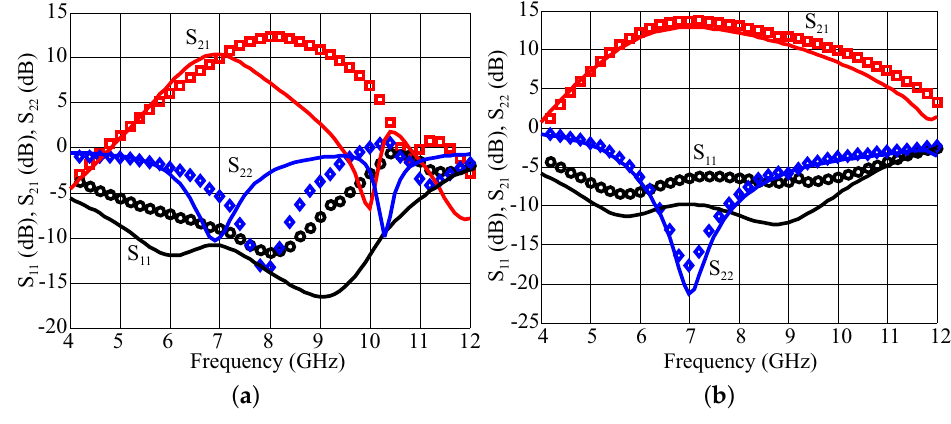
Figure 5. Scattering parameters in the band 4–12 GHz. Tuned Load ( a ), Harmonic Tuned ( b ) Power Amplifiers (PAs). Simulations: solid lines; measurements: symbols. S 11 : black circles, S 21 : red squares, S 22 : blue diamonds.